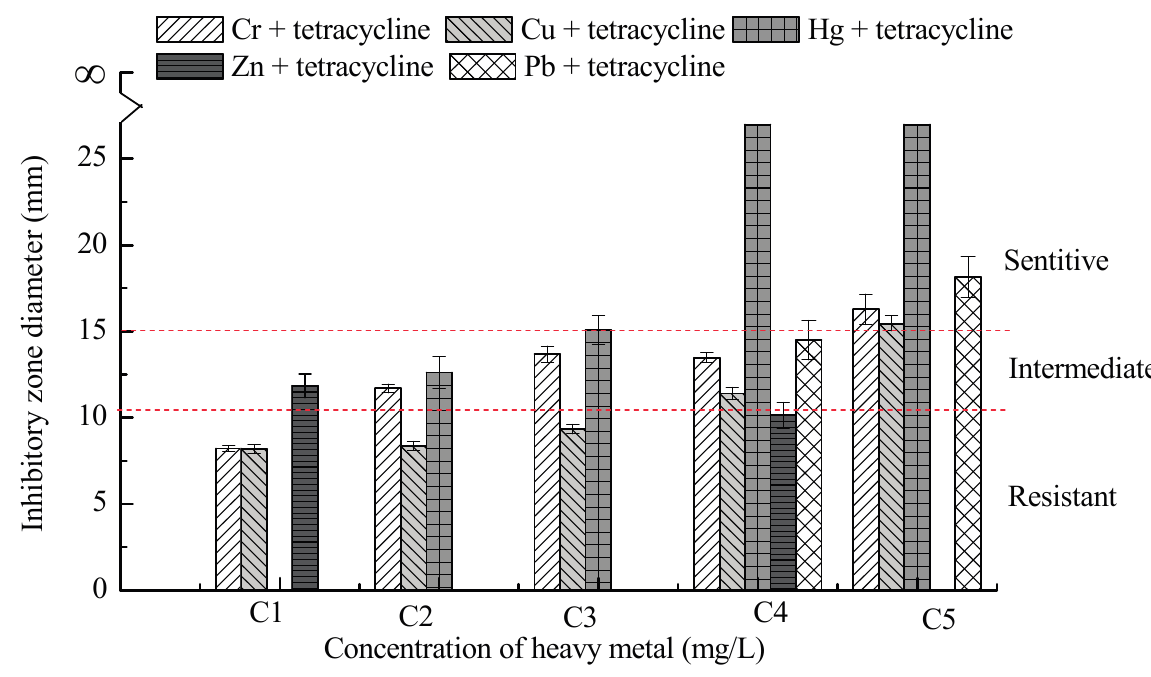
Figure 4. Effect of heavy metals on tetracycline resistance. Some histograms are not shown because their inhibition zone diameters were zero. Resistant, Intermediate and Sensitive were labeled according to the critical values of tetracycline in Table 1. C1, C2, C3, C4, C5 were the effective concentrations of each heavy metal in the medium, that is, Pb 2+ of 0.06, 1.66, 9.25, 49.37, 98.02 mg/L, Cu 2+ of 0.07, 1.66, 9.96, 46.17, 98.68 mg/L, Zn 2+ of 0.07, 1.78, 8.97, 44.96, 90.34 mg/L, Cr 6+ of 0.06, 1.88, 19.18, 46.70, 77.59 mg/L, and Hg 2+ of 0.07, 0.86, 4.96, 9.24, 19.38 mg/L,